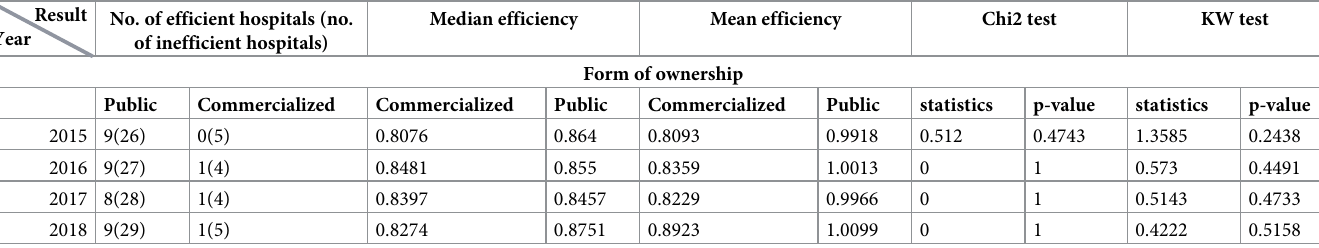
Table 11. Efficiency of hospitals with an ED with respect to the form of ownership ( traditional approach).